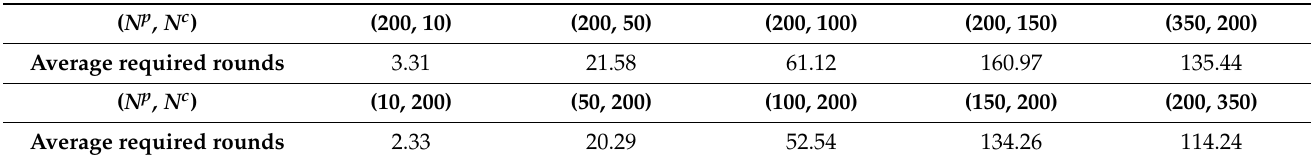
Table 4. Required rounds of running the proposed method with different numbers of providers and consumers as ( N p , N c